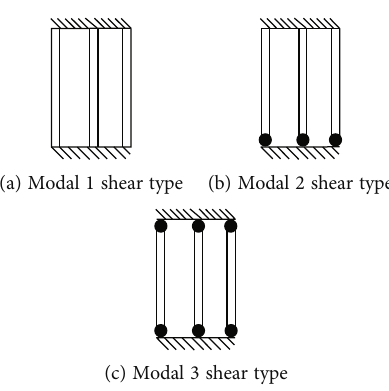
Figure 2: Yield mode of shear